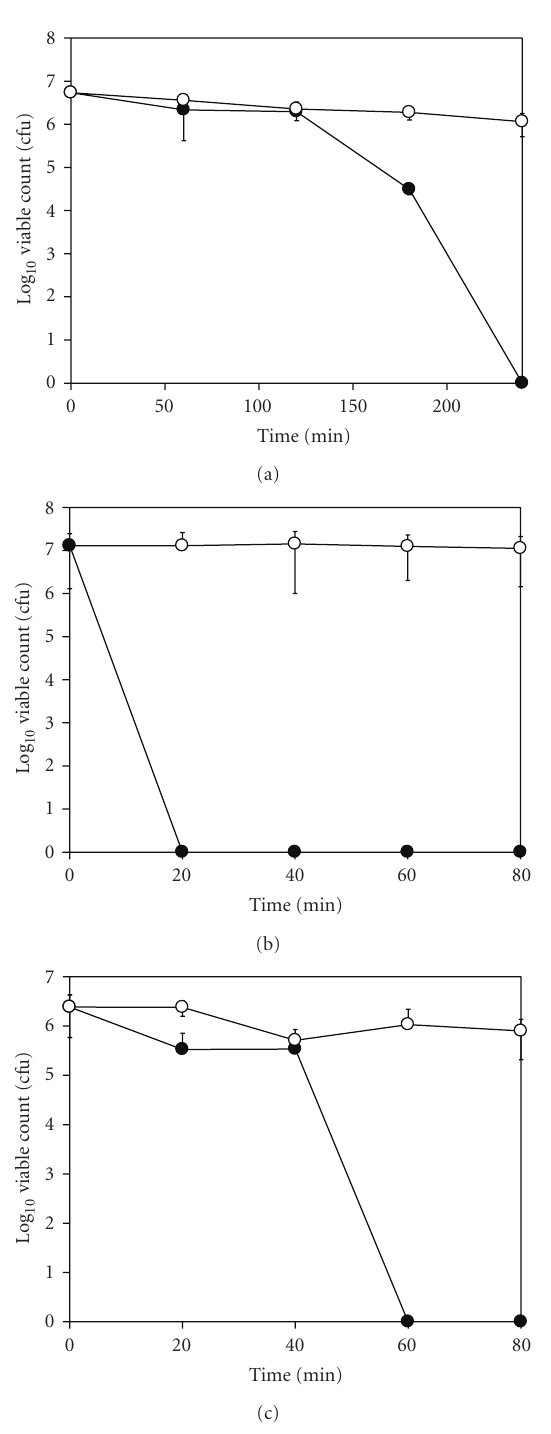
Figure 9: (a) Killing of E. coli on a TiO 2 film on glass • with control sample ◦ . (b) Killing of E. coli on Ag layer on glass (note: minimum test time 20 minutes) • with control sample ◦ . (c) Killing of E. coli on TiO 2 layer over Ag on glass • with control sample ◦ .